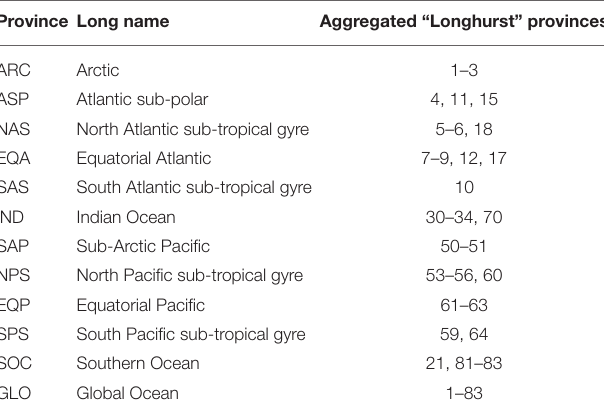
TABLE 1 | Summary of the ocean provinces used in this study and the codes of the 83 Longhurst provinces (Longhurst, 2007) used by Vichi et al. (2011), with the numbers corresponding to their Table 1 (Vichi et al., 2011).